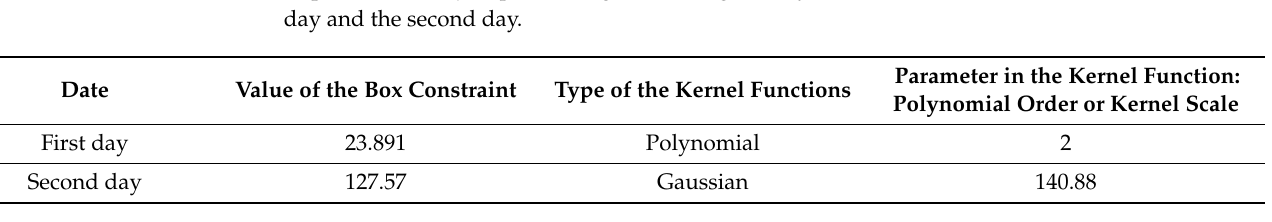
Table 12. The optimal parameters in the SVM in our proposed method trained using the EEGs acquired from Hejian performing the reading activity under the concentration state on both the first day and the second